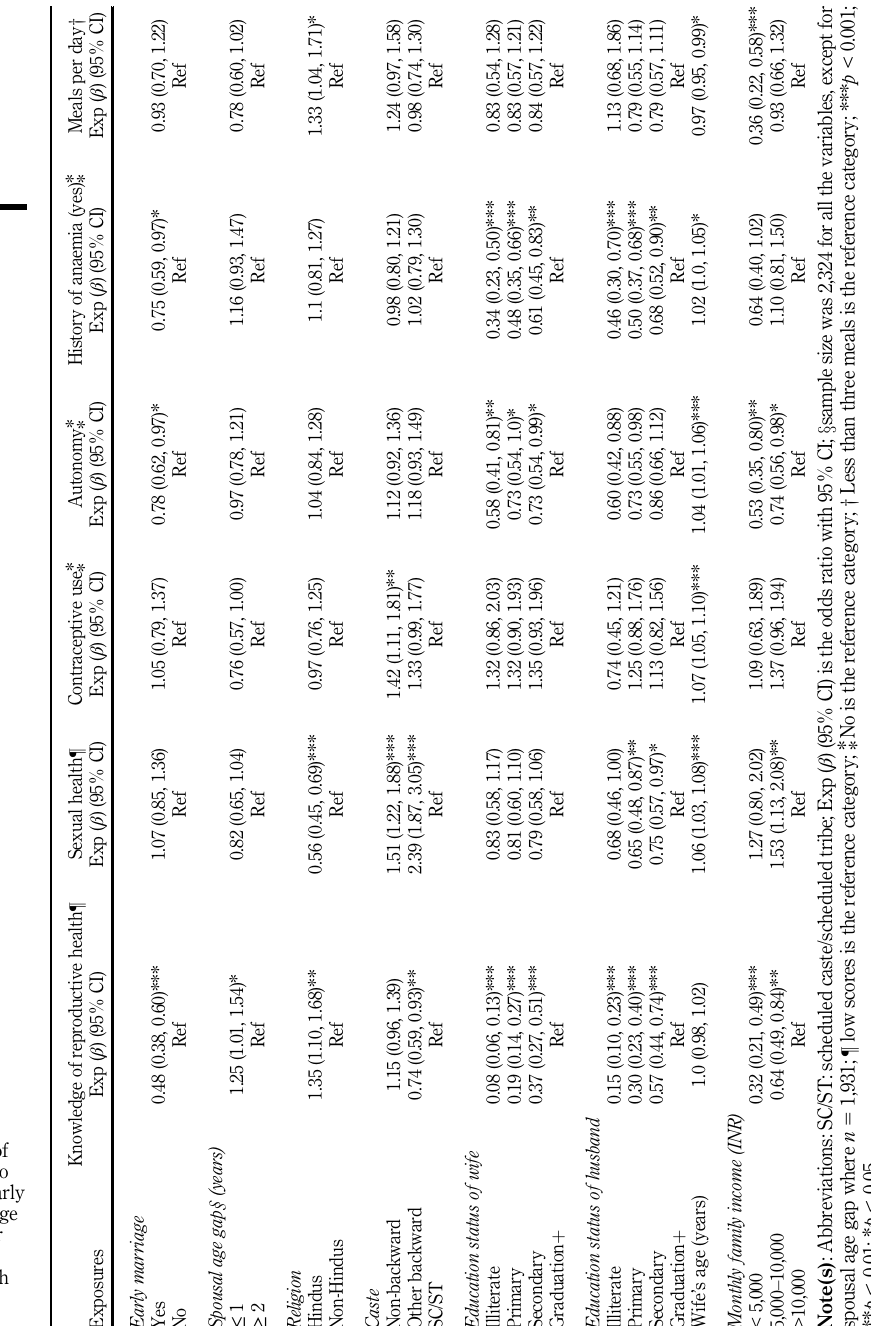
Table 3. Unadjusted model of logistic regression to assess the link of early marriage, spousal age difference and other exposures with preconception health